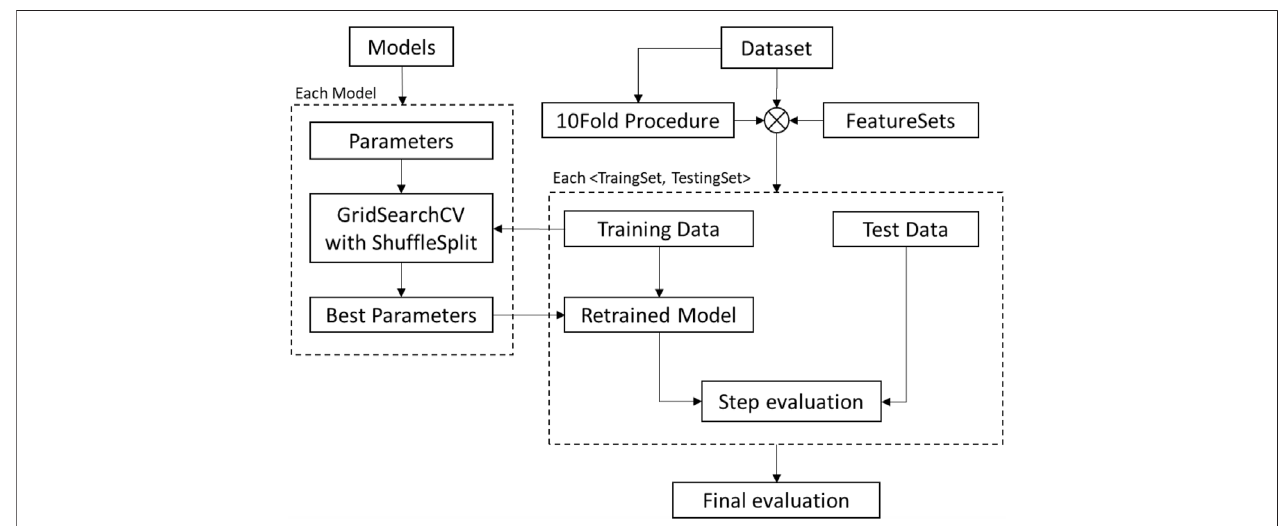
FIGURE 5 | The fl owchart of the cross-validation work fl ow from the scratch to evaluate the performance of each model after feature selection.